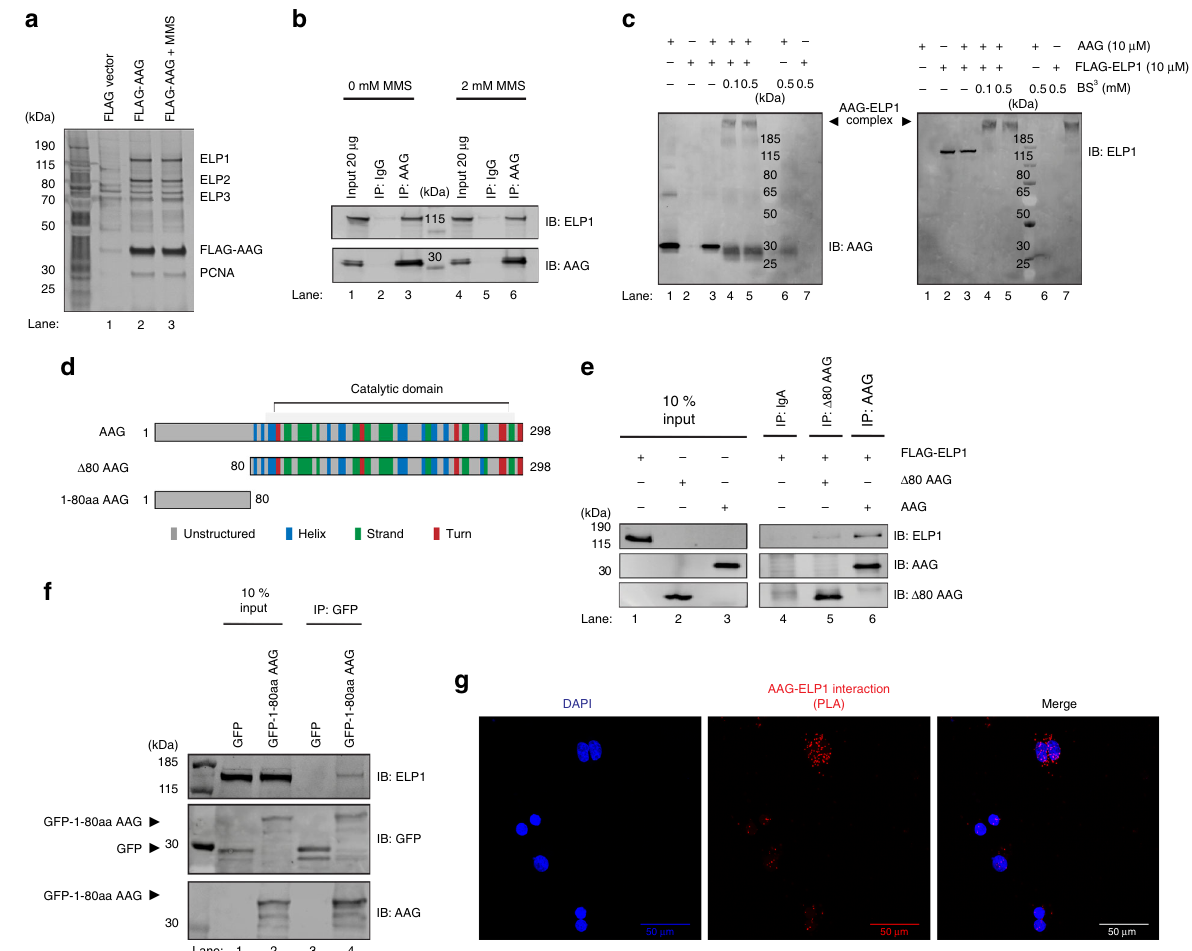
Fig. 2 AAG directly interacts with ELP1 subunit of transcriptional Elongator complex. a Silver staining analysis of untreated or MMS (methyl methanesulfonate) treated FLAG-AAG immunoprecipitation (IP) samples subjected to LC/MS-MS analysis. IP sample from HEK293T cells transfected with empty FLAG vector served as negative control. LC/MS-MS analysis of FLAG-AAG IP samples identi fi ed ELP1 as the most speci fi cally enriched AAG interacting partner. Remaining subunits of core Elongator (ELP2 and 3), and known interacting partner PCNA are depicted. See also Supplementary Data 2 for the complete list of proteins identi fi ed in all samples. b IP of AAG from HEK293T whole cell extracts (WCEs) treated or untreated with MMS. c Immunoblot analysis of gel shift experiments with puri fi ed recombinant AAG and FLAG-ELP1 proteins, and chemical crosslinking with indicated amounts of BS 3 (bissulfosuccinimidyl suberate). Control samples – proteins in the absence of crosslinking agent (lanes 1-3); and single proteins with highest amount of BS 3 (lanes 6, 7). d Schematic representation of full-length AAG, AAG lacking 80 N-terminal amino acids ( Δ 80 AAG), and fi rst 80 N-terminal amino acids of AAG (1-80aa AAG); numbers indicate amino acids. e Co-IP of puri fi ed FLAG-ELP1 with AAG full length, or AAG lacking 80 N-terminal amino acids ( Δ 80 AAG). f IP of GFP-tagged fi rst 80 N-terminal amino acids of AAG (1-80aa AAG) (GFP-1-80aa AAG) expressed in HEK293T AAG − / − cells. GFP-tag positioned N-terminally. g Proximity ligation assay (PLA) showing the AAG-ELP1 interaction in HEK293T cells. Scale bar: 50 μ m. Source data are provided as a Source Data fi